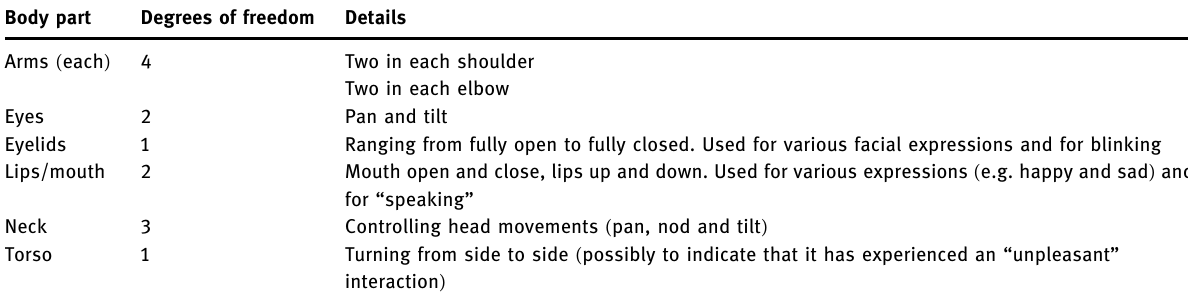
Table 2: Kaspar ’ s degrees of freedom Body part